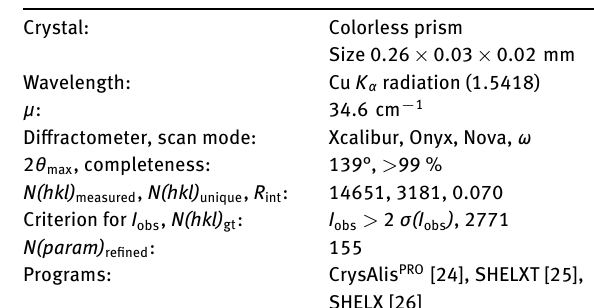
Table 1: Data collection and handling.